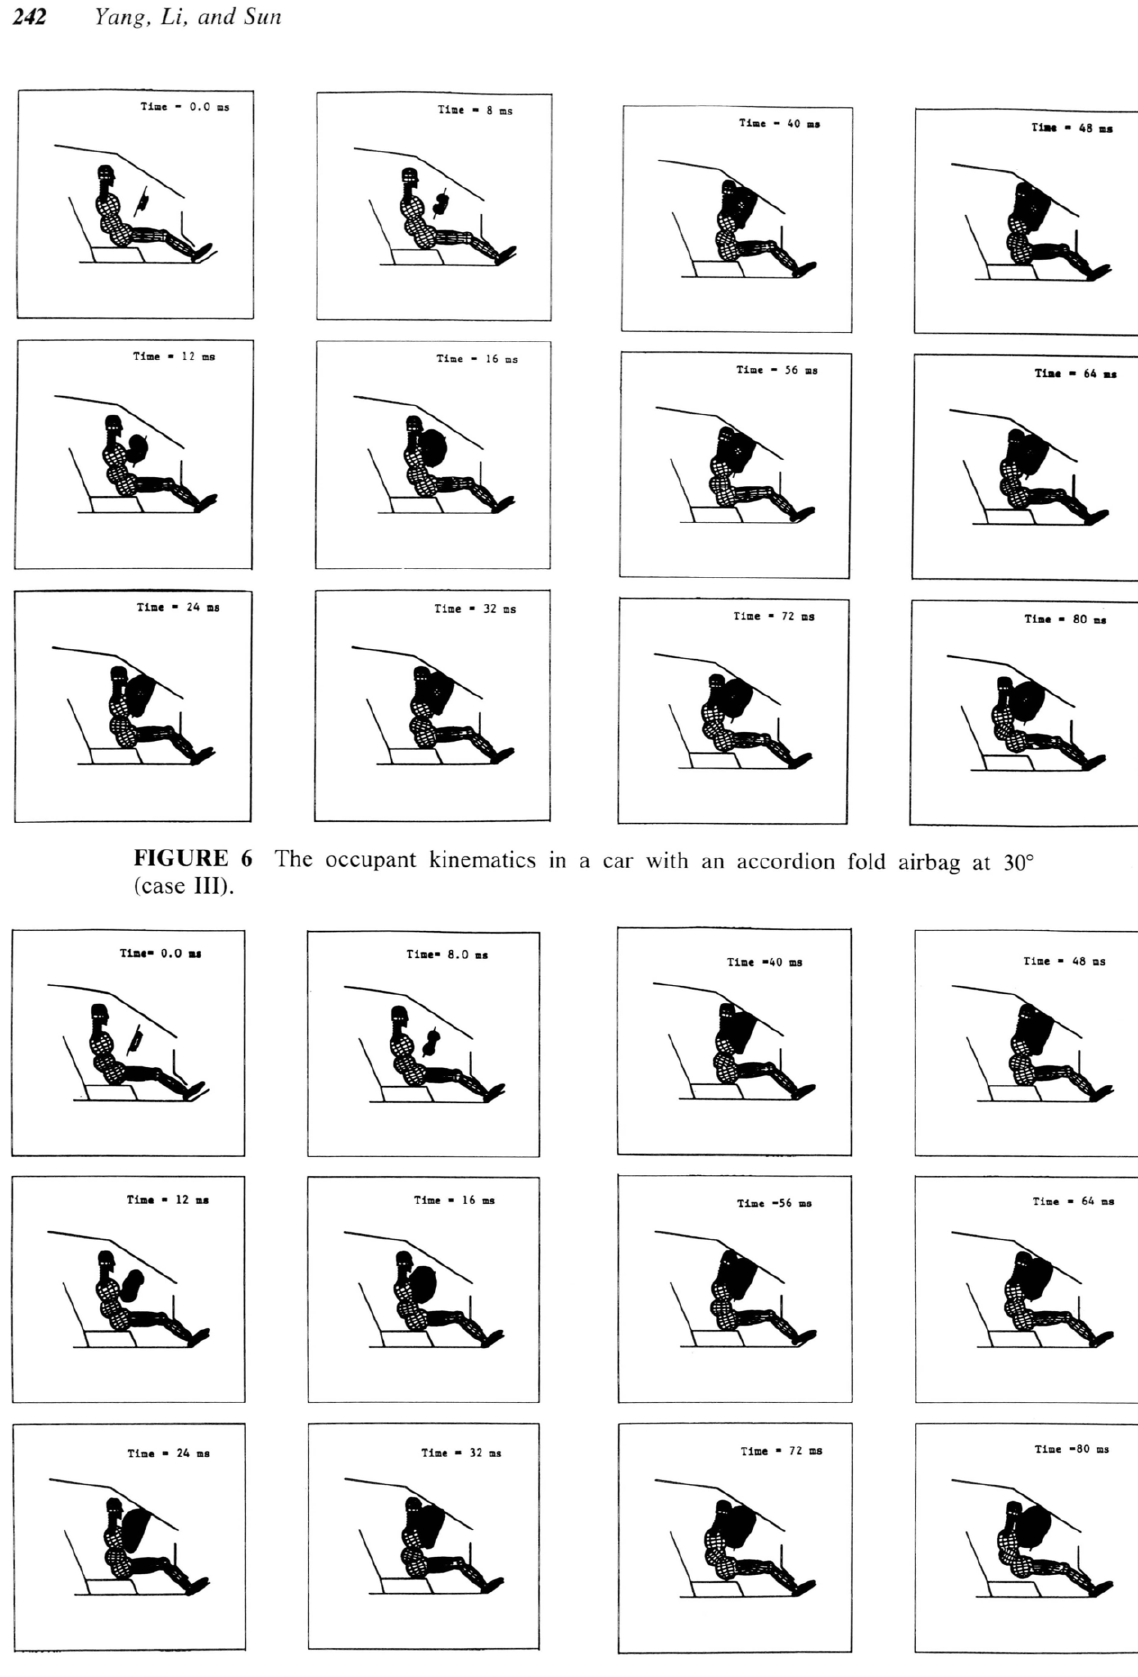
FIGURE 7 The occupant kinematics in a car with a pleated accordion fold airbag at 30° (case